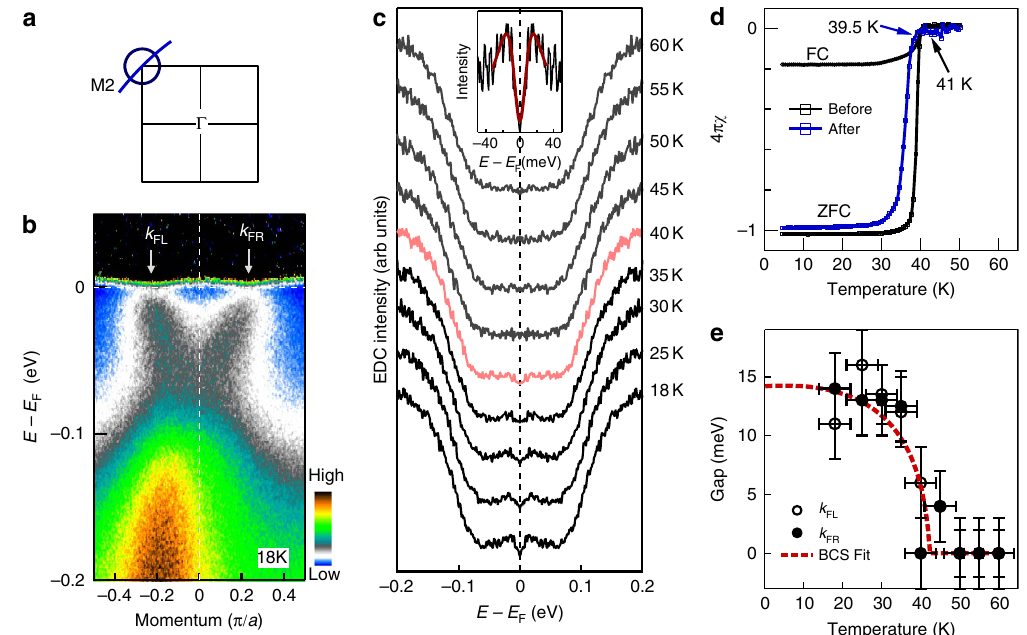
Figure 3 | Temperature dependence of the superconducting gap of the (Li 0.84 Fe 0.16 )OHFe 0.98 Se superconductor. ( a ) Schematically, the electron-like Fermi surface near M2 point and the location of the momentum cut (blue line) across the Fermi surface. ( b ) Photoemission image measured at 18K along the momentum cut near the M2 point (blue line in a ). The data are divided by the corresponding Fermi distribution function, to highlight the opening of an energy gap around the Fermi level (the original data can be found in Fig. 2a). Two Fermi momenta are marked by arrows as k FL and k FR . ( c ). Symmetrized photoemission spectra (EDCs) at the Fermi momentum k FL measured at different temperatures. The middle-top inset shows the expanded region of the 18K symmetrized EDC around the Fermi level and the fitting result (red line) using the formula from ref. 50 to get the gap size. ( d ) Magnetic measurement of the superconducting transition temperature ( T c ) for the (Li 0.84 Fe 0.16 )OHFe 0.98 Se sample we measured. Both field-cooled (FC) and zero-filed-cooled (ZFC) mode measurements show an onset T c at B 41K with a sharp transition width of B 1.5K. ( e ) Temperature dependence of the measured superconducting gap. The gap size is obtained by picking up the peak position from the symmetrized EDCs ( c ) or by fitting the near- E F symmetrized EDCs using the formula from ref. 50; both approaches give similar results within experimental uncertainty. The error bars are defined as s.d. The gap size from EDCs of both the left Fermi momentum ( k FL ) and the right Fermi momentum ( k FR ) are plotted. The red dashed line is a BCS gap form with a gap size of B 14meV at 0